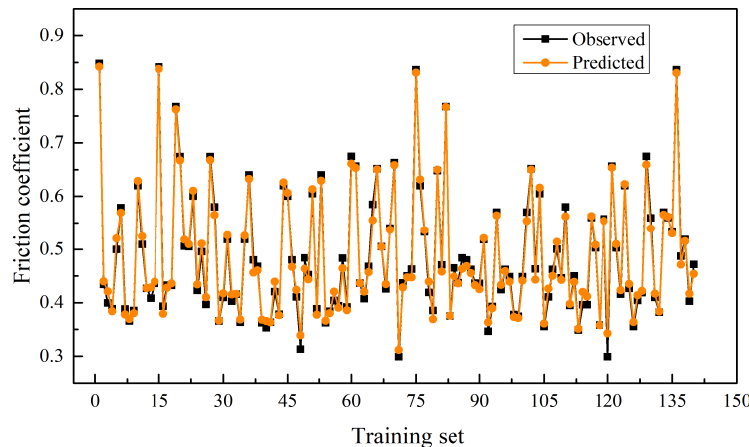
Figure 14. The histograms of the data distribution of macrotexture parameters and friction coeffi- cients.